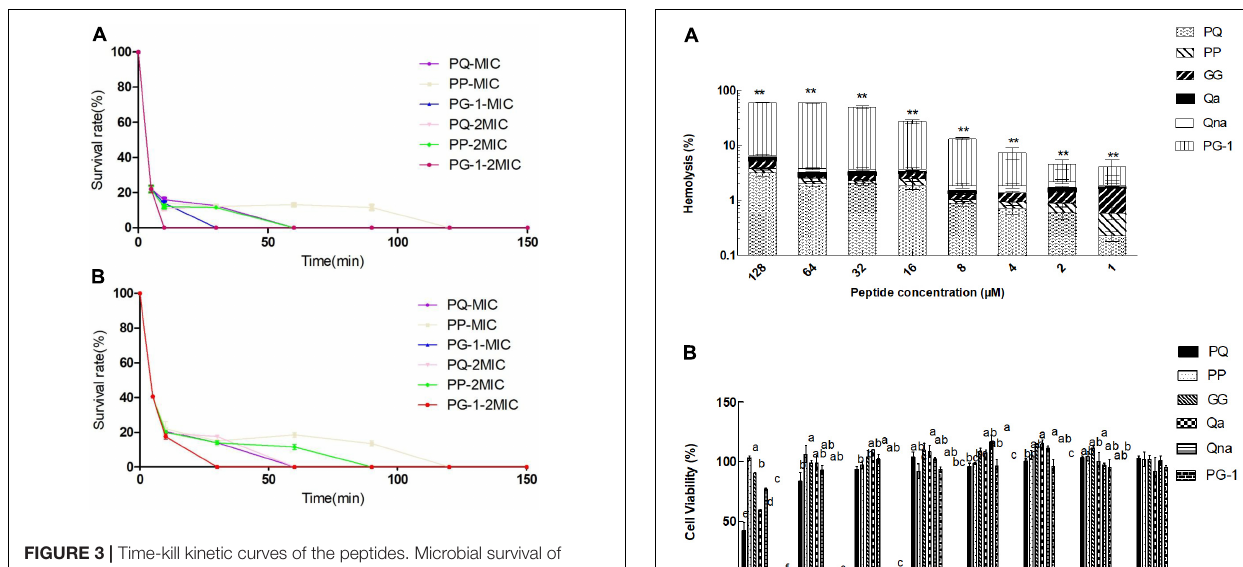
FIGURE 3 | Time-kill kinetic curves of the peptides. Microbial survival of Escherichia coli (A) and S. aureus (B) after 5, 10, 30, 60, 90, 120, and 150 min of treatment with peptides at MIC and 2 × MIC.